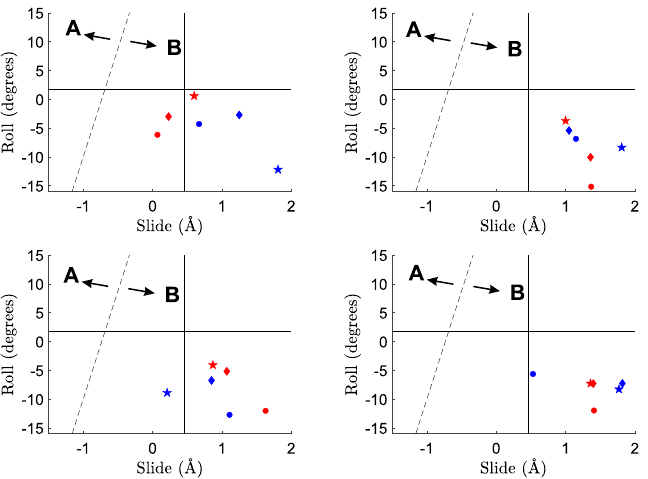
Figure 6. Predicted slide and roll coordinates of double-stranded tetramers. ( Top ): M06-2X; ( bottom ): B3LYP-D3. ( Left ): 6-31G(d,p); ( right ): TZVP. Blue: ds-G 4 ; red: ds-A 4 . • : 5 (cid:48) -B ( 1 ) /B ( 2 ) steps; (cid:7) B ( 2 ) /B ( 3 ) steps; and (cid:70) : B ( 3 ) /B ( 4 ) -3 (cid:48) steps. The average slide and roll of the starting calf-thymus B-DNA conformation are reported as full lines. The dashed line separates the A- and B-DNA forms